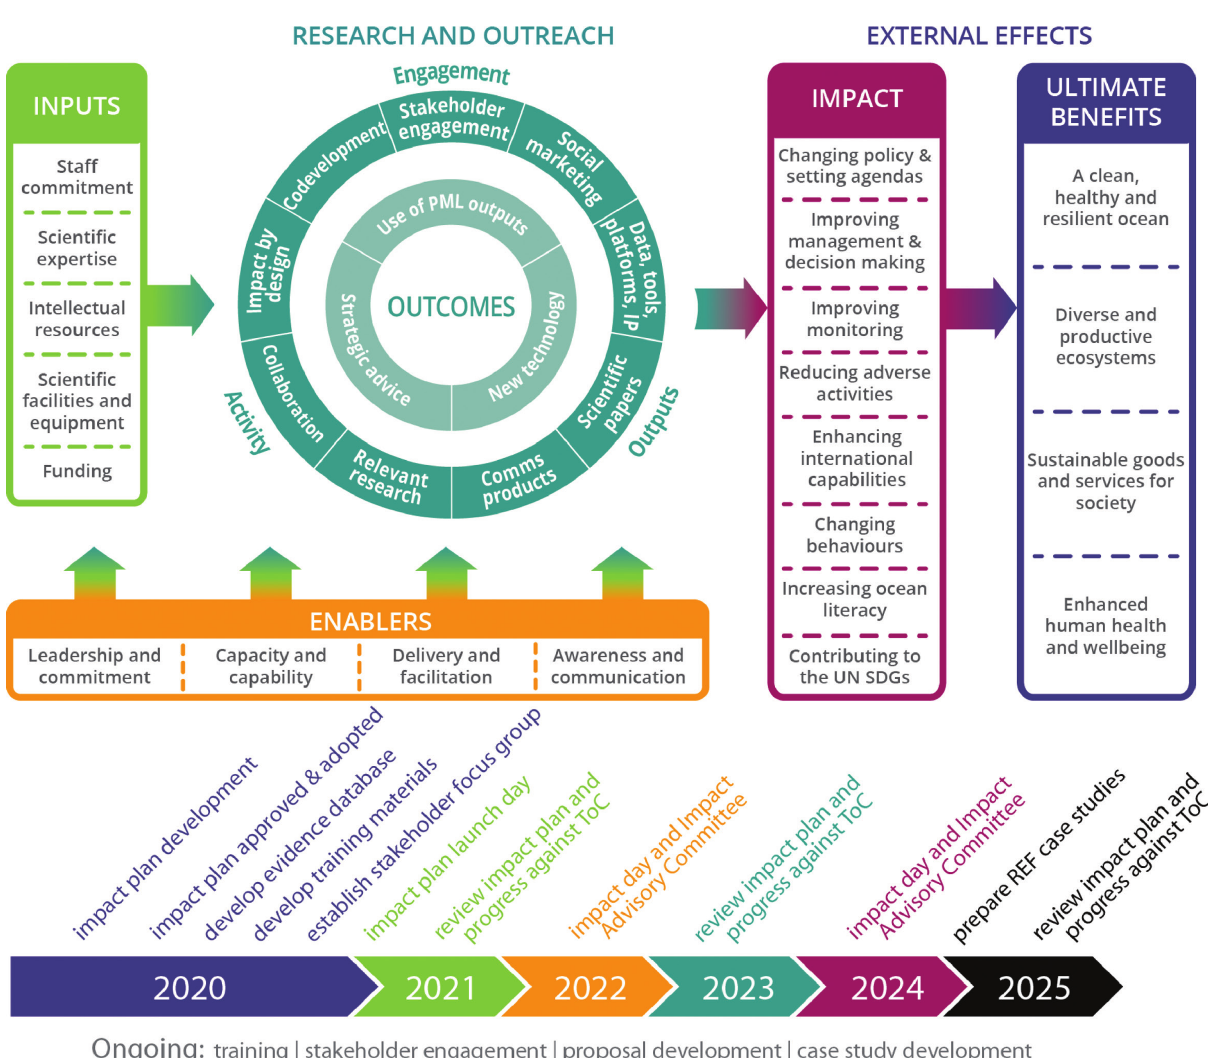
Figure 3. Theory of change (top) and implementation plan (bottom) from Plymouth Marine